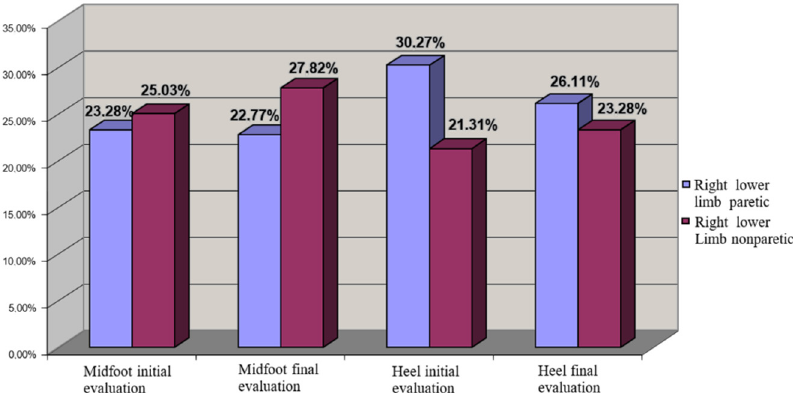
Figure 8. COP distribution for left hemiplegia (left lower limb nonparetic—cu grena, right lower limb paretic).